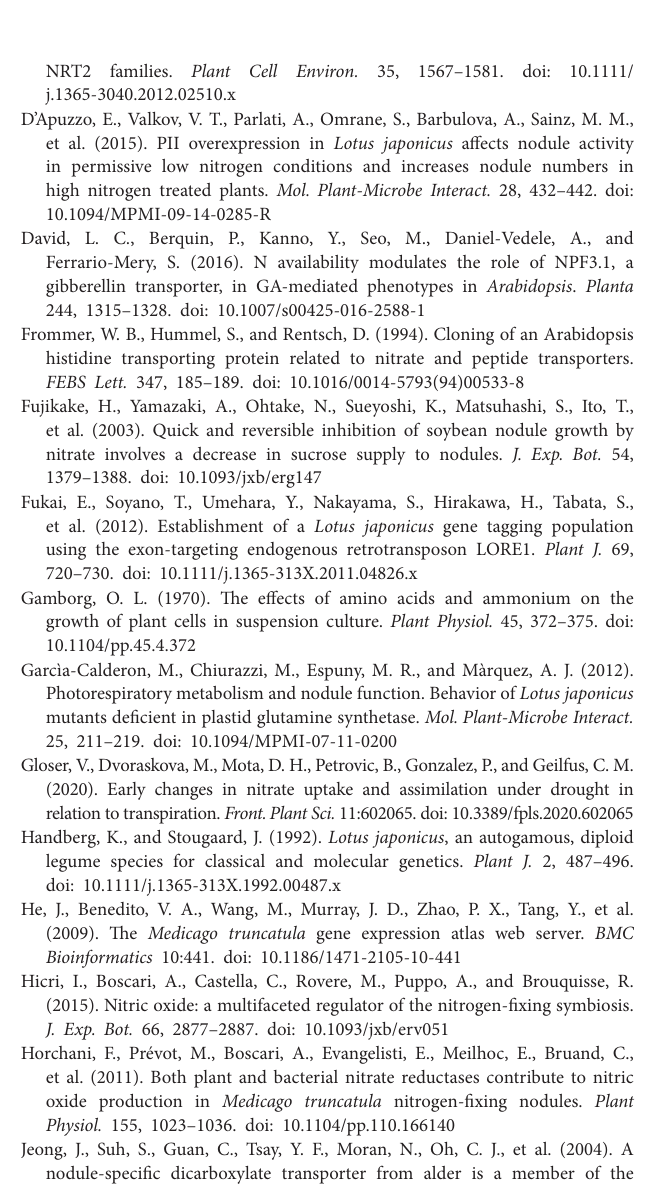
Supplementary Figure S2 | Representative images of the wild-type and Ljnpf3.1 plants at 6 weeks after inoculation. Nitrate condition and plant genotypes are indicated. The white arrows are pointed on stems of mutants displaying evident accumulation of anthocyanin. Supplementary Figure S3 | Phenotypic characterization of Ljnpf3.1-1 and Ljnpf3.1-2 mutants. (A) Fresh weight of detached leaves. (B) The dry weight of detached leaves. Plants were grown in Petri dishes, in the presence of 1 mM KNO 3 . Leaves from single plants were detached and immediately weighted at 4 weeks after inoculation. Bars represent the means and SE of measures from three experiments (12 plants per experiment). Asterisks indicate significant differences with wild-type levels. * p < 0.05. Supplementary Table S1 | Oligonucleotides are used in the present work. Supplementary Table S2 | Description of the Lotus japonicus NPF clade